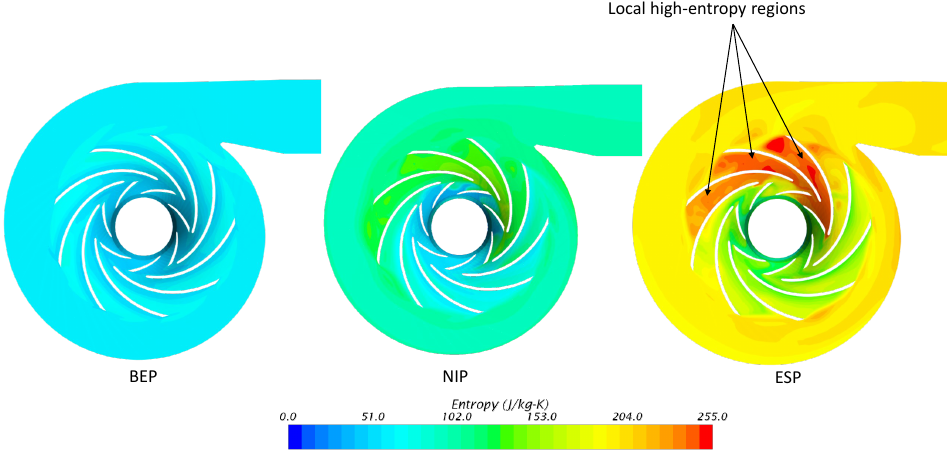
Figure 10. Entropy distribution on 0.5 span surface.